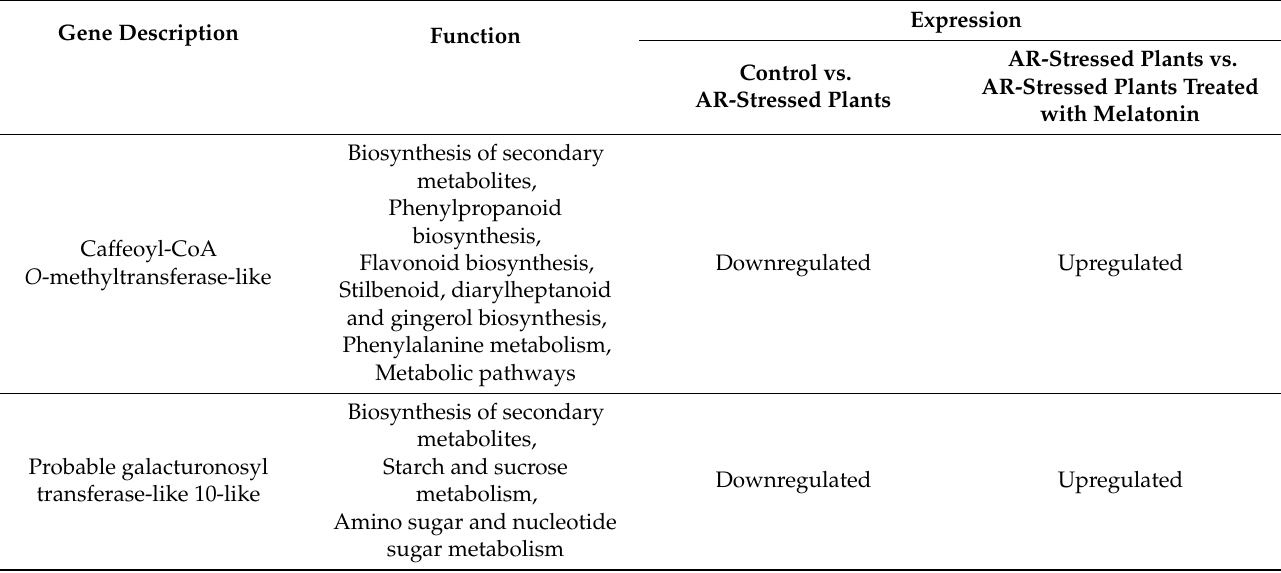
Table 1. Expression of differentially expressed genes (DEGs) through RNA sequence (log2 fold change) and qRT-PCR fold changes in tomato plant under AR stress conditions and melatonin supplementation [18]. Gene Description